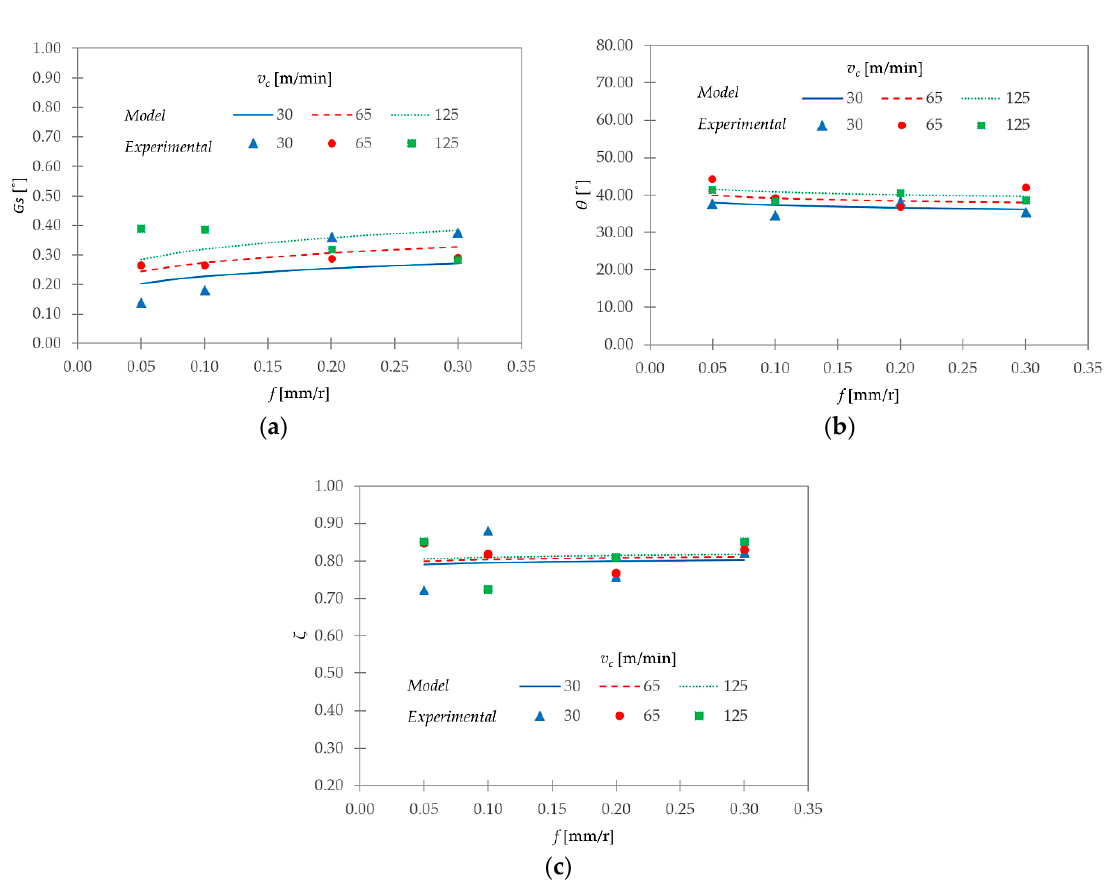
Figure 16. Comparisons between the experimental data and the proposed model for ( a ) G s , ( b ) θ , and ( c ) ζ .